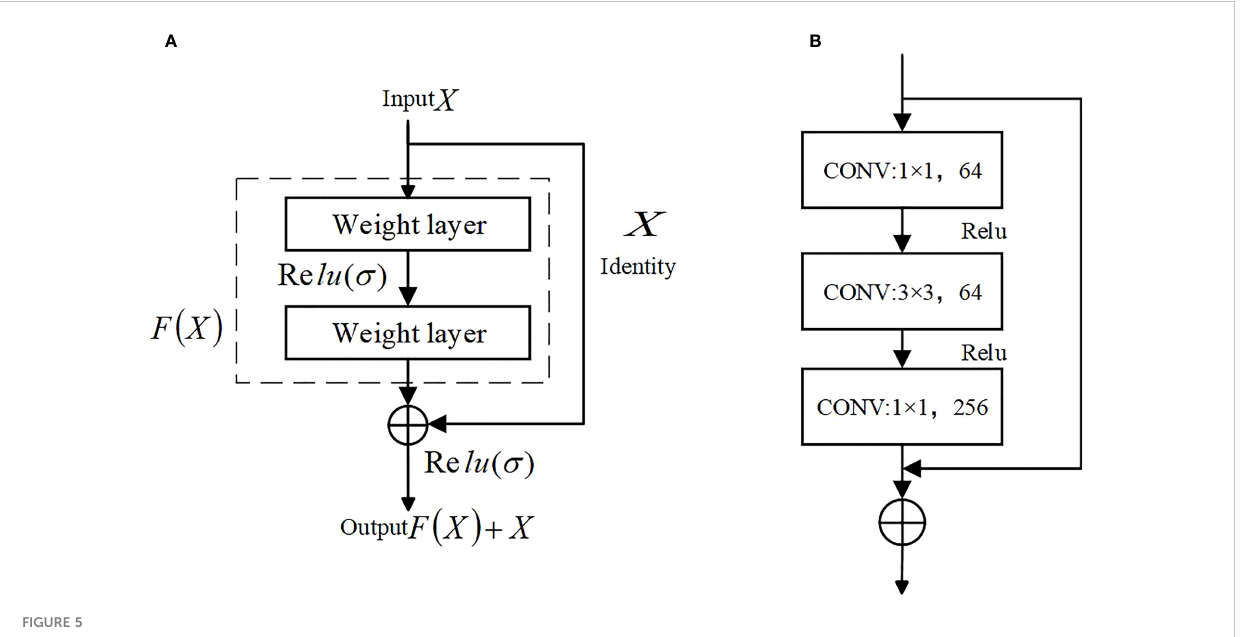
FIGURE 5 Residual structure. (A) Residual structure, (B) Bottleneck residual